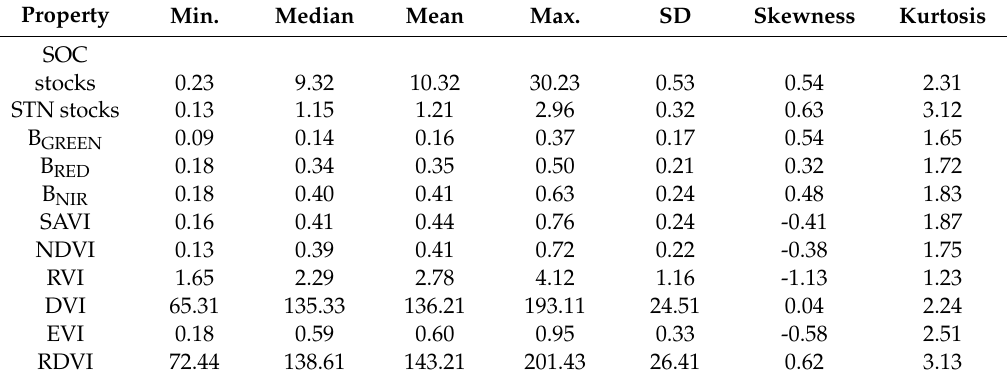
Table 1. Summary statistics of topsoil (0–30 cm) soil organic carbon (SOC) stocks (kg m − 2 ), soil total nitrogen (STN) stocks (kg m − 2 ), and remote sensing environment variables at sample sites. Property Min.